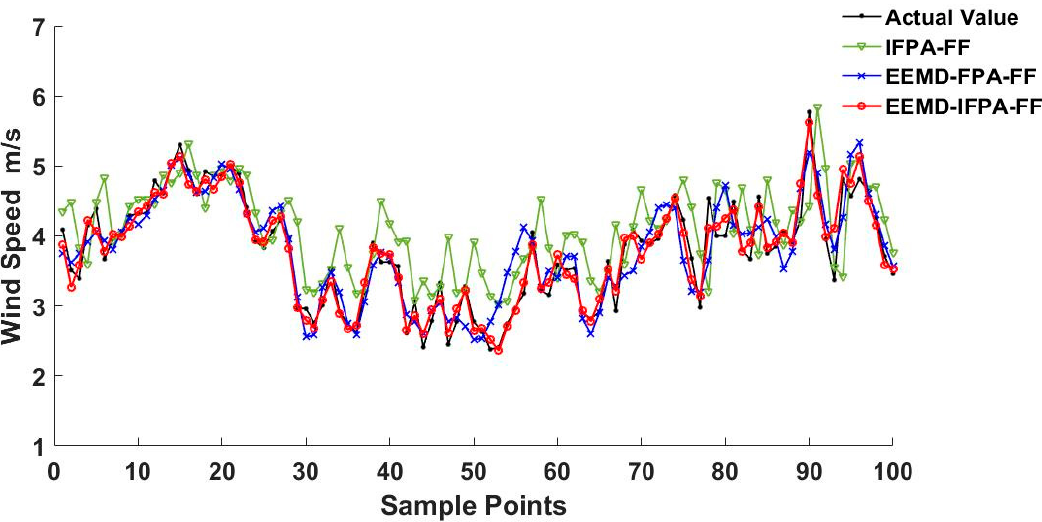
Figure 12. Wind speed prediction on 13 February.